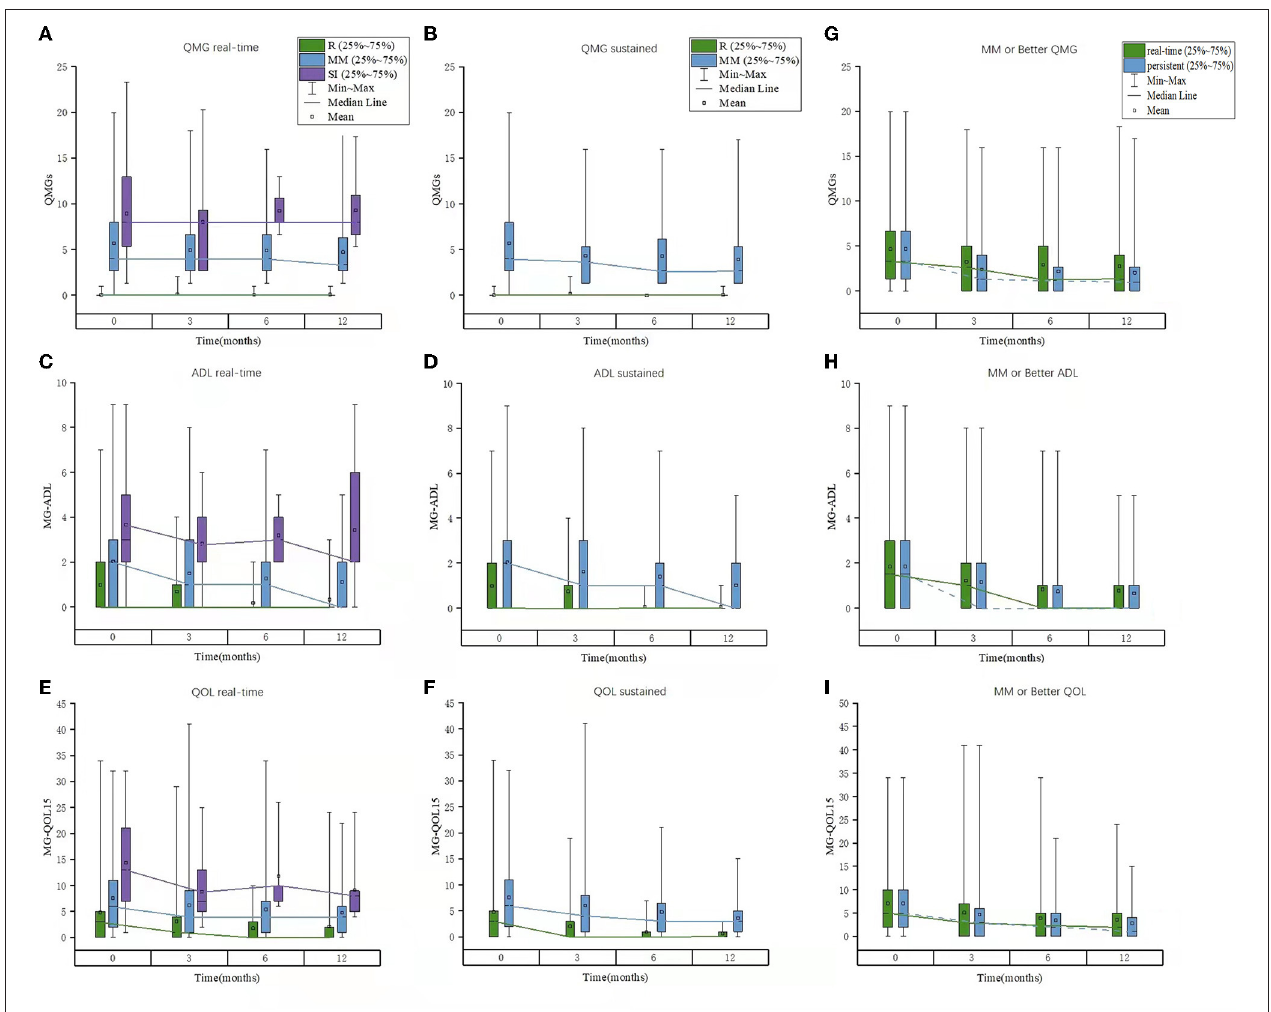
FIGURE 3 | The scores of QMGS, MG-ADL, and MG-QOL15 in patients belonging to each PIS category or “MM or better” status at each follow-up in the whole cohort. (A–C) Real-time; (D–F) Sustained; (E–I) “MM or better” status. QMGS, quantitative myasthenia gravis score; ADL, activities of daily living; QOL, quality of life; PIS, post-intervention status; MM, minimal